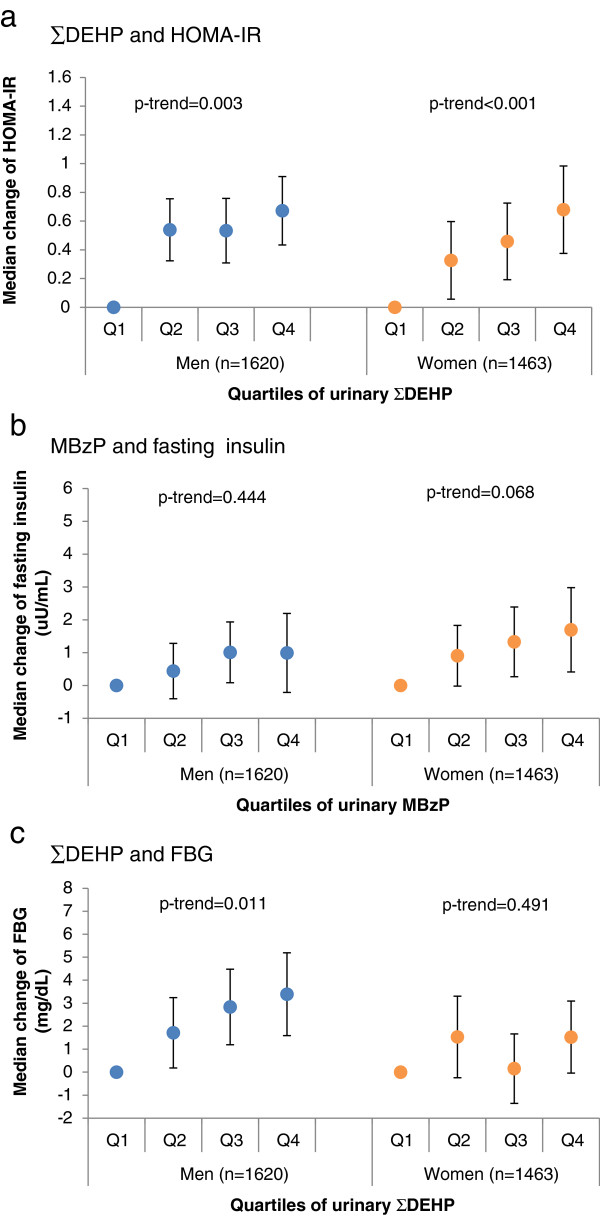
Change in markers of diabetes risk across quartiles of markers of diabetes risk in men and women. One example is selected for each pattern. (a) example of similar strength of association: ∑DEHP and HOMA-IR, most associations show similar gender patterns, (b) example of stronger association in women: MBzP and fasting insulin, (c) example of stronger association in men: ∑DEHP and FBG. Adjusted for age, race, urinary creatinine, fasting time, total caloric intake, triglyceride, education, smoking status and poverty for all phthalate metabolites.